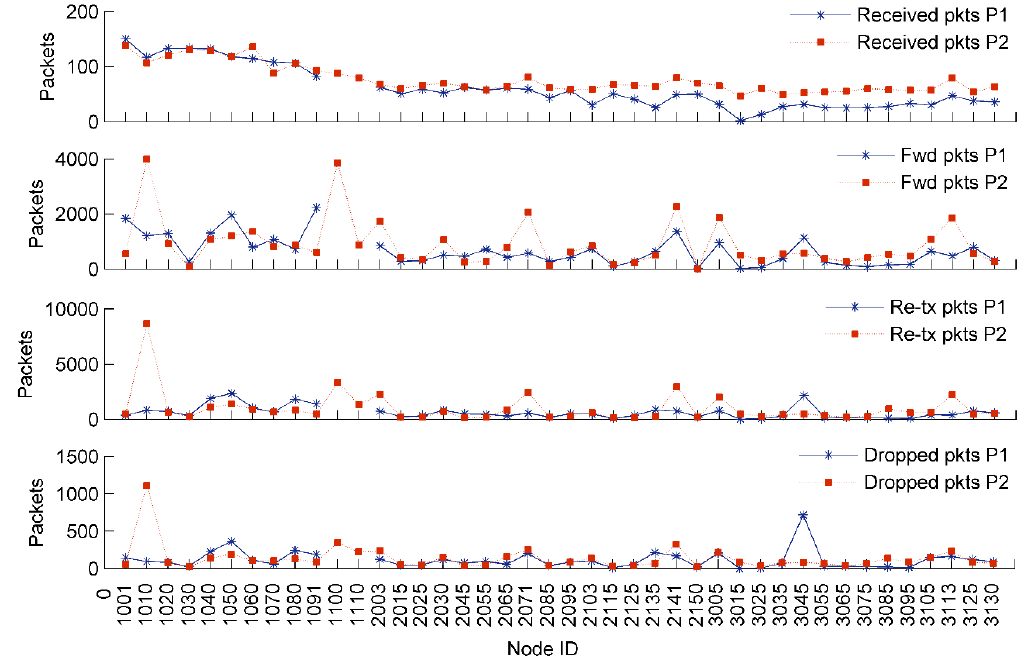
Figure 8. Daily average node packets received, packets forwarded, packets retransmitted and packets dropped per node during XMesh evaluation periods P1 and